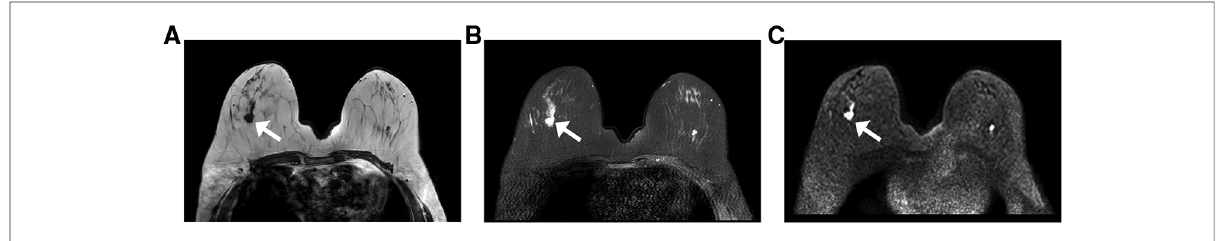
FIGURE 3 MRI from a 63-year-old woman with a palpable abnormality in the right breast the MRI shows an irregular mass with a spiculated margin in the upper outer quadrant. The tumor exhibits the following characteristics: ( A ) a low signal on the T1WI; ( B ) a high signal on the fat-suppressed T2WI; and ( C ) a high signal on the DWI (white arrows indicate the locations of lesions). Abbreviations: MRI, magnetic resonance imaging; T1WI, T1-weighted imaging; T2WI, T2-weighted imaging; DWI, diffusion-weighted imaging.